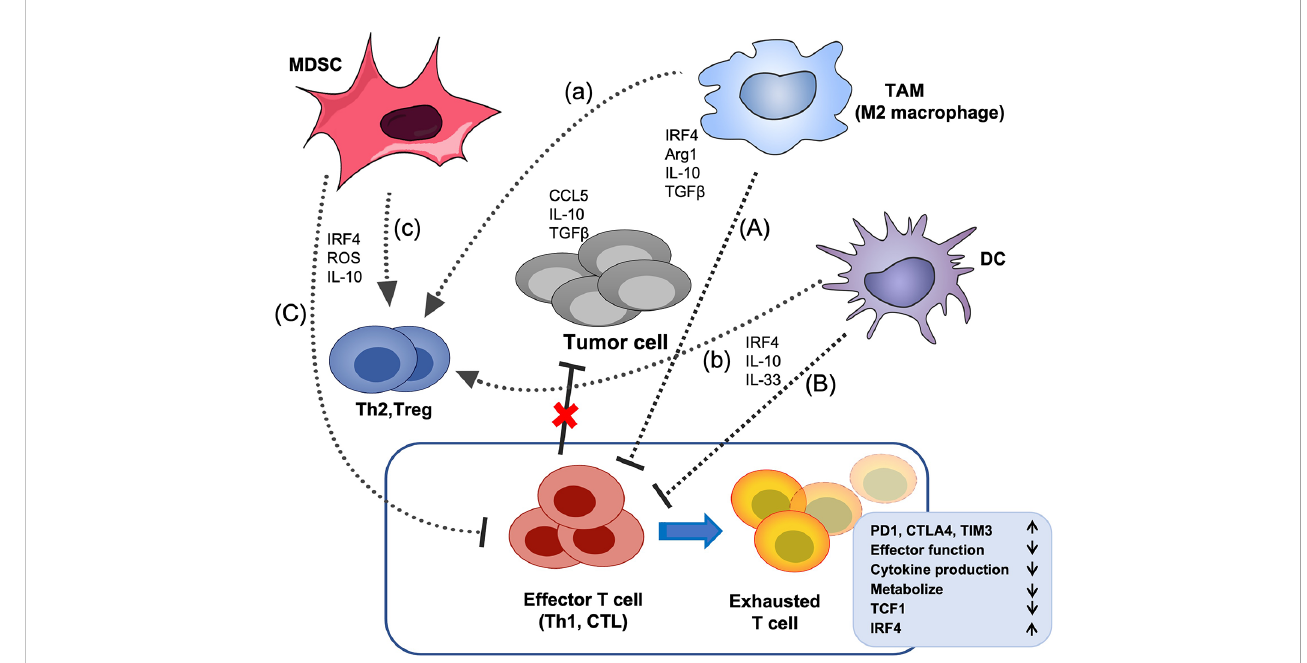
FIGURE 4 The effects of IRF4 on the crosstalk between immunosuppressive cells and T cells in the TME. Tumor cells and multiple soluble chemokines and cytokines recruit and induced various immunosuppressive cells, such as MDSCs, TAMs and DCs to the TME, which further aggravate the TME disorder and promote tumor growth. These myeloid derived immunosuppressive cells can suppress the effector function of CTL and Th1 cells and promote the differentiation of Treg cells and Th2 cells. In addition, tumor-related antigens stimulate the abnormal activation of effector T cells, ultimately, lead to the CD8+ T cell exhaustion, characterized by up-regulation of multiple inhibitory receptors, progressive loss of effector function and impaired differentiation of memory T cells, etc. IRF4 plays critical roles in the generation of various immunosuppressive cells, and the above crosstalk between myeloid derived immunosuppressive cells and effector T cells (A – C) and Treg cells (a-c) in the TME. The black arrow indicates promotion, the black horizontal line indicates inhibition, and the red cross indicates that the anti-tumor activity of effector T cells is